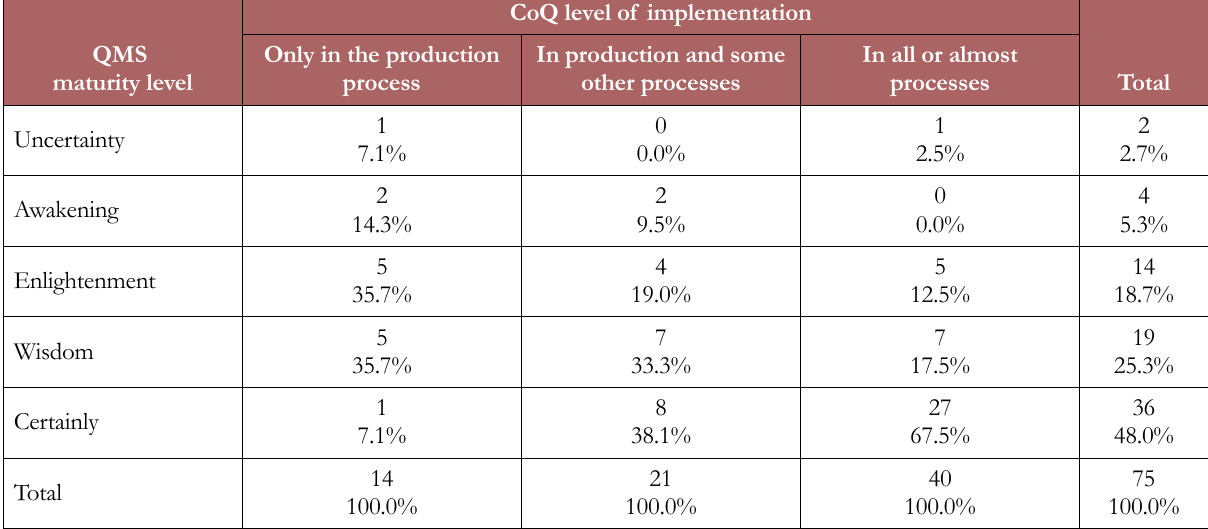
Table 9. CoQ level implementation* QMS Maturity level